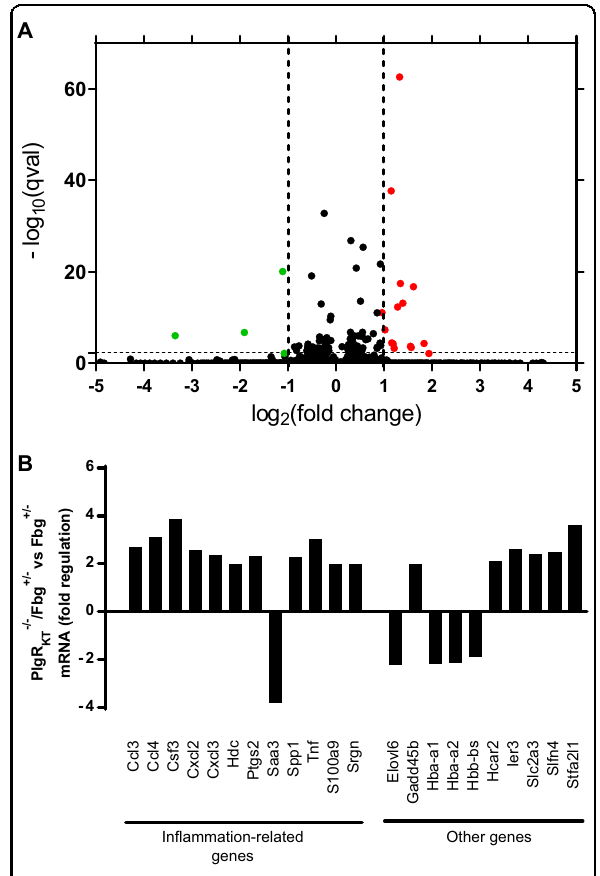
Fig. 8 Gene expression in Plg-R KT − / − / fi brinogen + /- and Plg-R KT + / + / fi brinogen + / − wound tissue. mRNA sequencing of Plg-R Plg-R KT + / + wound tissue on a Fibrinogen + / − (Fbg + / − ) genetic background was carried out on samples taken at day 11 ( n = 4). All the genes had corrected p value ≤ 0.05. A Volcano plots with genes upregulated > 1.0-fold in Plg-R KT − / − / fi brinogen + / − tissue shown in red, genes downregulated < 1.0 fold in Plg-R KT − / − / fi brinogen + / − tissue shown in green and unregulated genes shown in black. B Genes whose expression changed by ≥ 1.5-fold tissue in Plg-R KT − / − / fi brinogen + / −